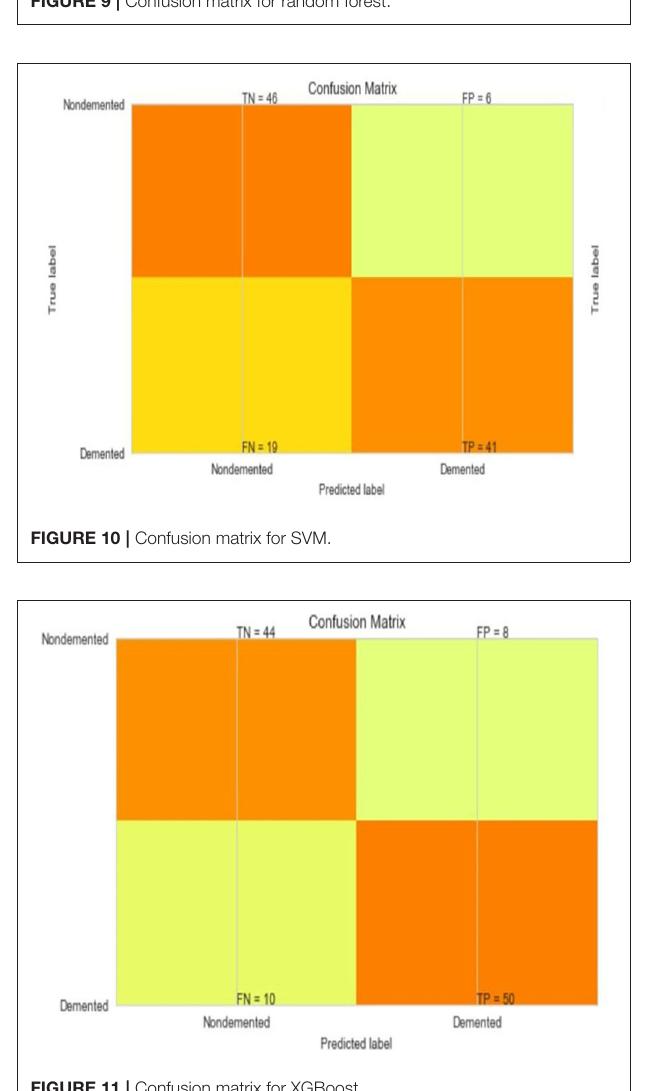
FIGURE 11 | Confusion matrix for XGBoost.